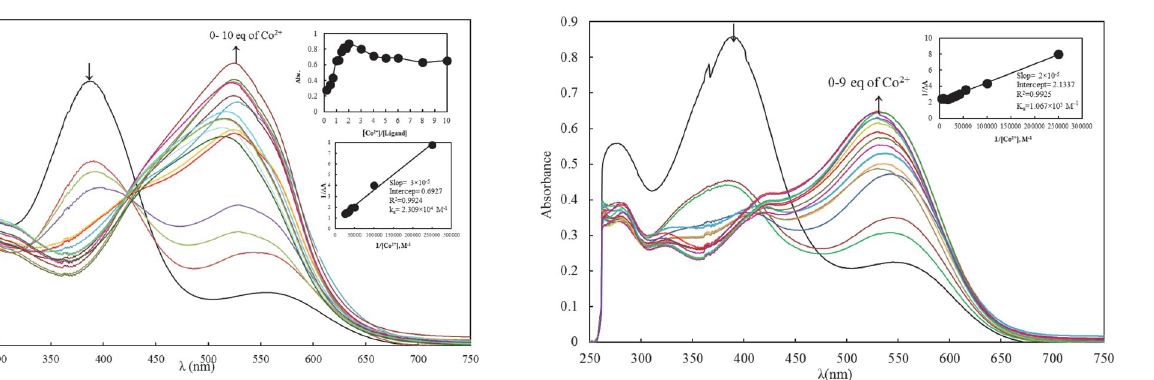
Fig. 6 . Changes in the UV–vis spectra of 1 upon titration by Co(CH 3 COO) 2 in a DMSO solution, where the concentration of Co(CH 3 COO) 2 varies from 0.004–0.2 mM. Insets: above: Absorp- tion at selected wavelength versus equivalents of cation added, down; Benesi–Hildebrand plot of the receptor with Co 2+ ion.